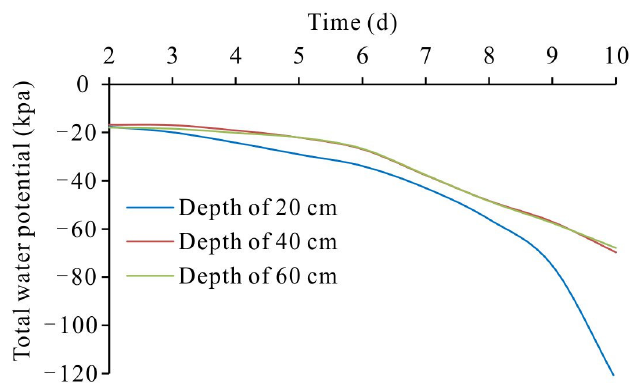
Figure 12. Changes in total water potential at different depths in the control zone.